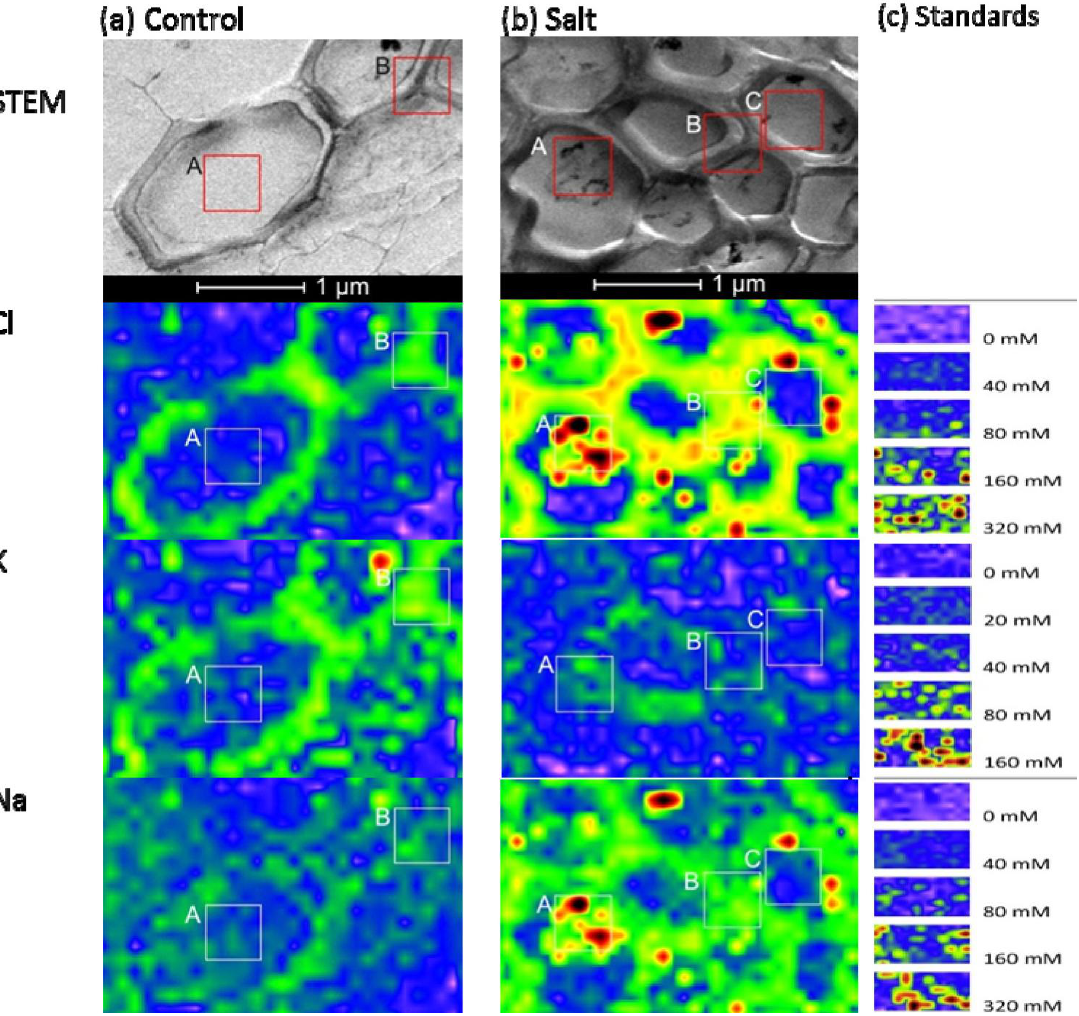
Figure 5. Representative STEM images and elemental images of xylem vessels in control ( a ) and NaCl-treated P. euphratica ( b ). For X-ray imaging, the areas measured in xylem vessels depended on the cell structures of interest. The spatial resolution ranged from 50 nm  50 nm to 100 nm  100 nm. Elemental images of 5% agar standards ( c ) were acquired at the same resolutions. The maximum and minimum pixel intensities were fixed in these images for agar and root specimen as described in Figure 4. Frames A, B, and C were used to calculate the mean intensities (Table